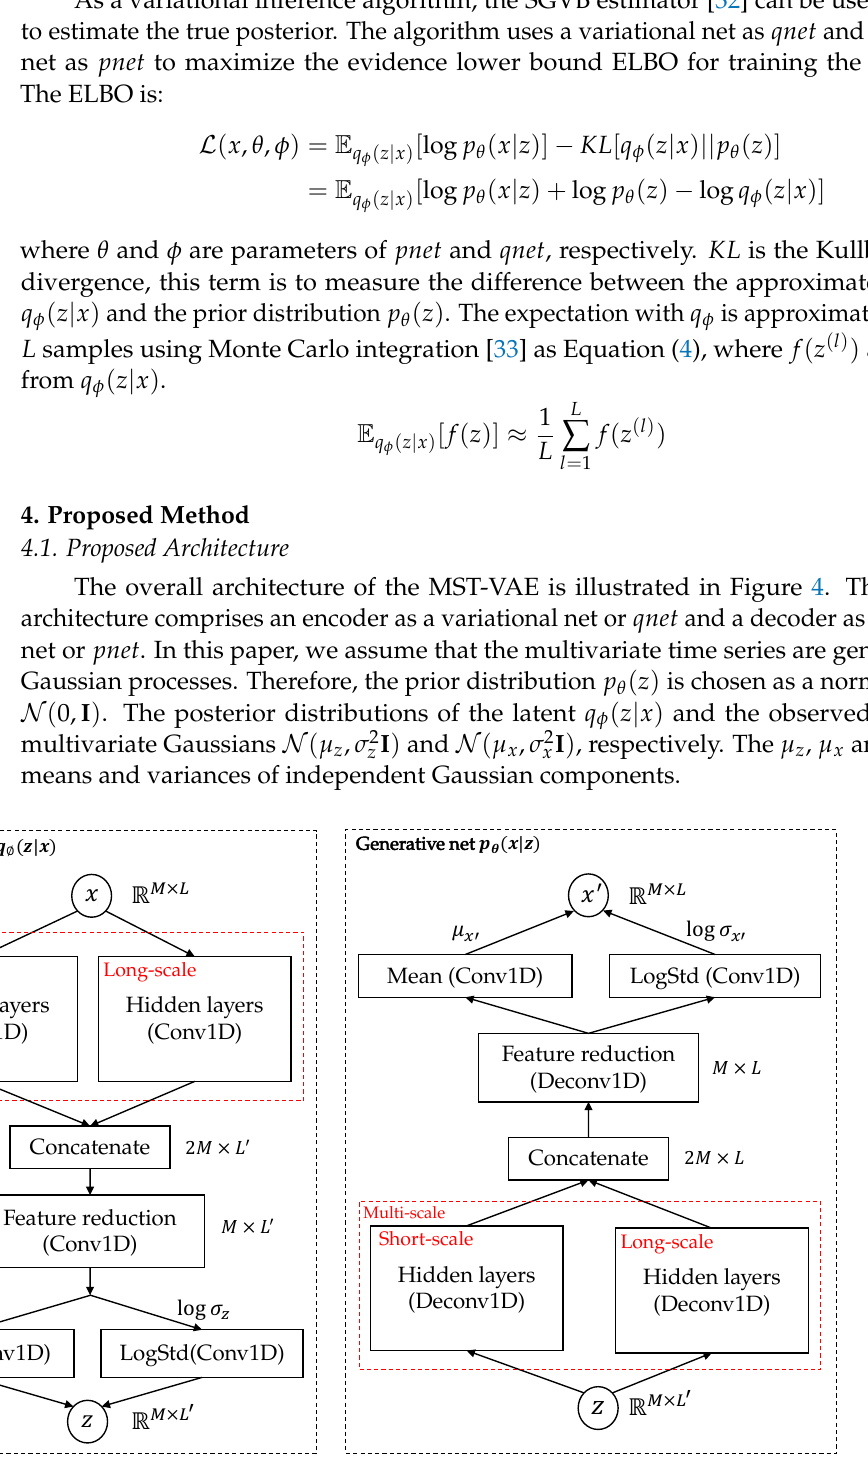
Figure 4. Overall architecture of MST-VAE. Circles are stochastic variables, black rectangles are layers, and red dashed rectangles are multi-scale